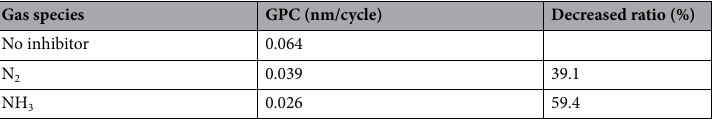
Table 1. GPC of SiO 2 PE-ALD with various inhibition conditions and decreased ratio compared with the no inhibitor case.